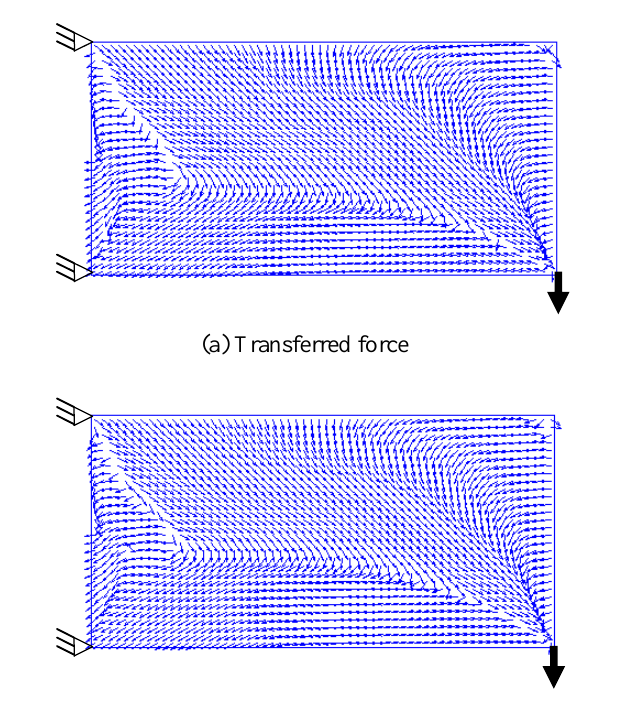
Fig. 9. Orientations f the transferred and potential trans- ferred